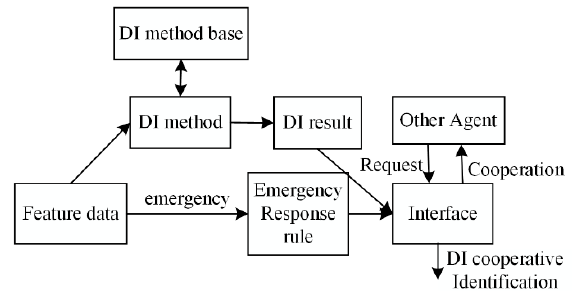
Figure 5. The internal structure and principle of the DFA .